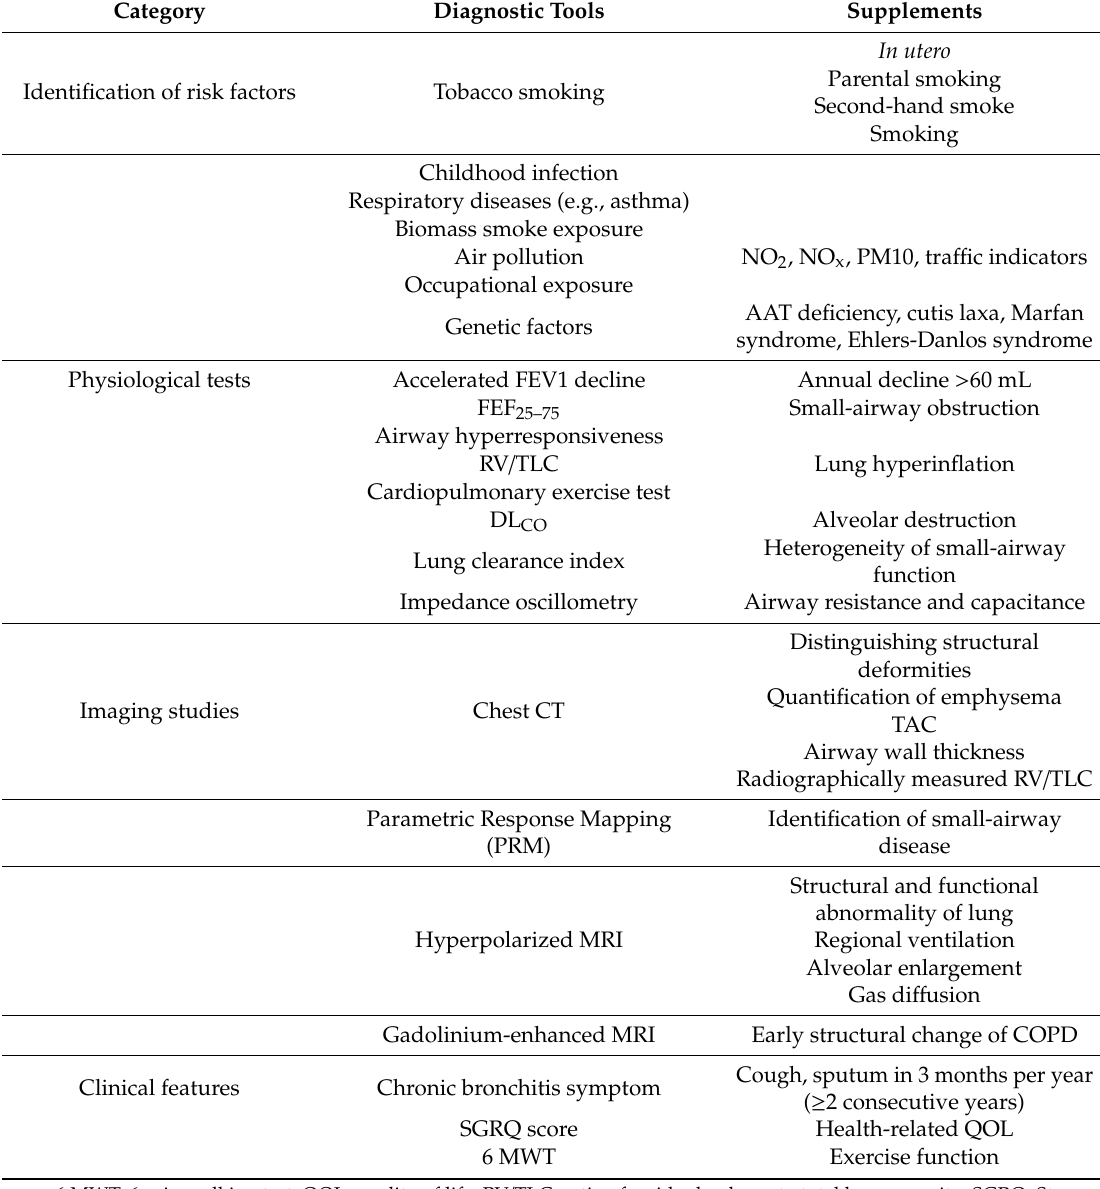
Table 1. Diagnostic tools for early